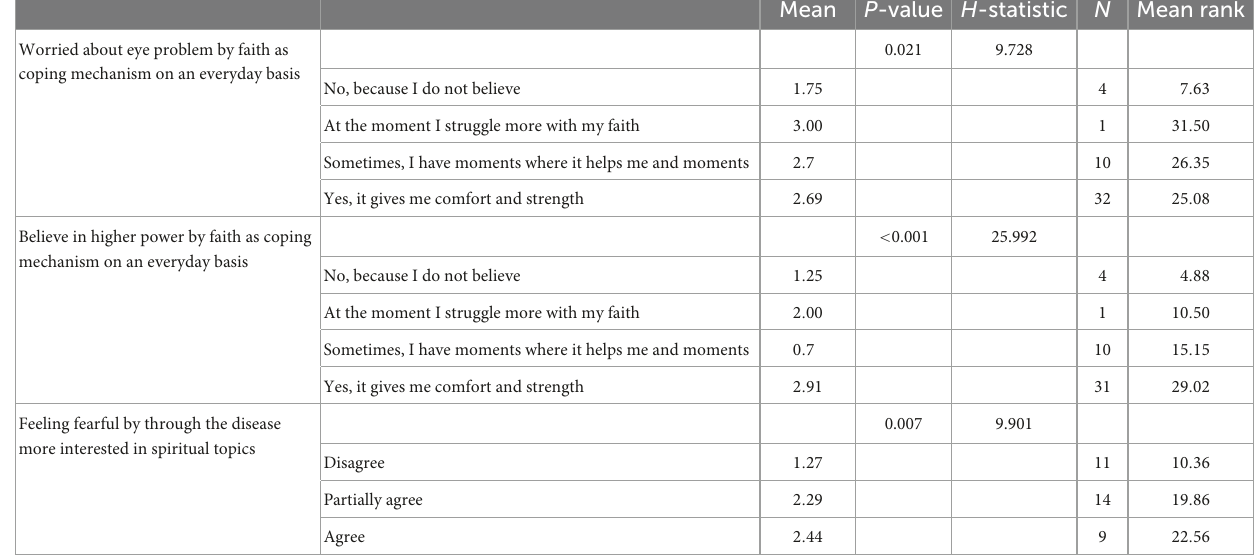
TABLE 5 The results of the Kruskal–Wallis test for the Romanian